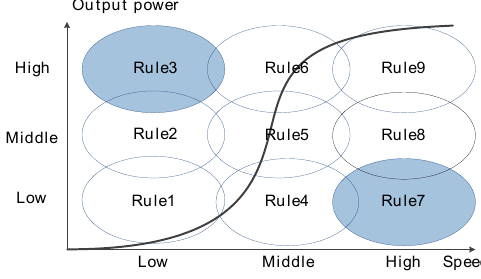
Figure 2. Domain knowledge rules.